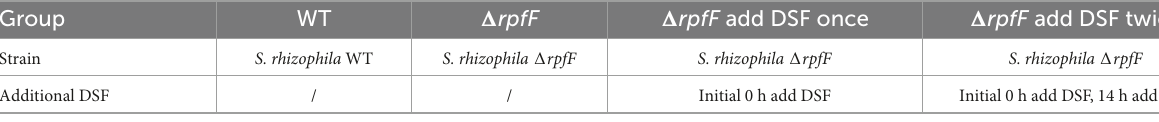
TABLE 2 Experiment on seed germination under saline-alkaline stress. Group